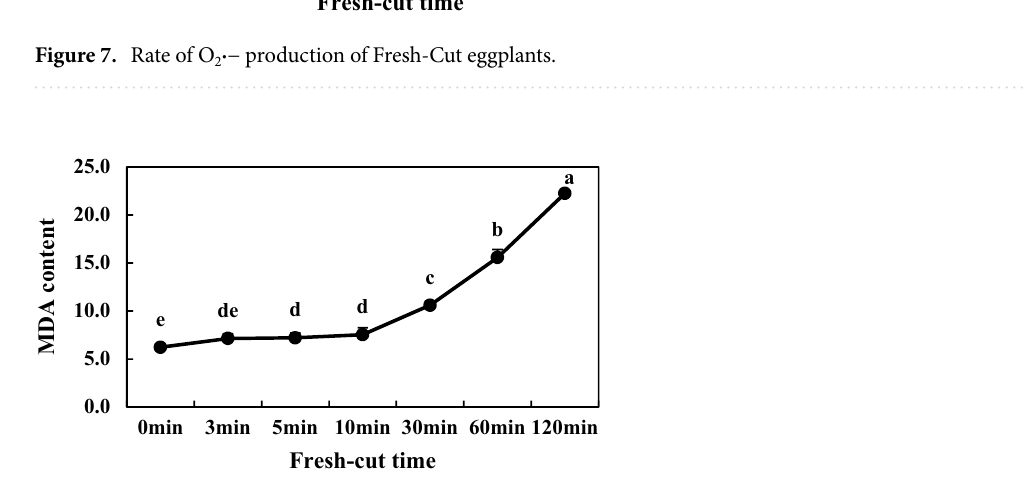
Figure 8. MDA content of Fresh-Cut